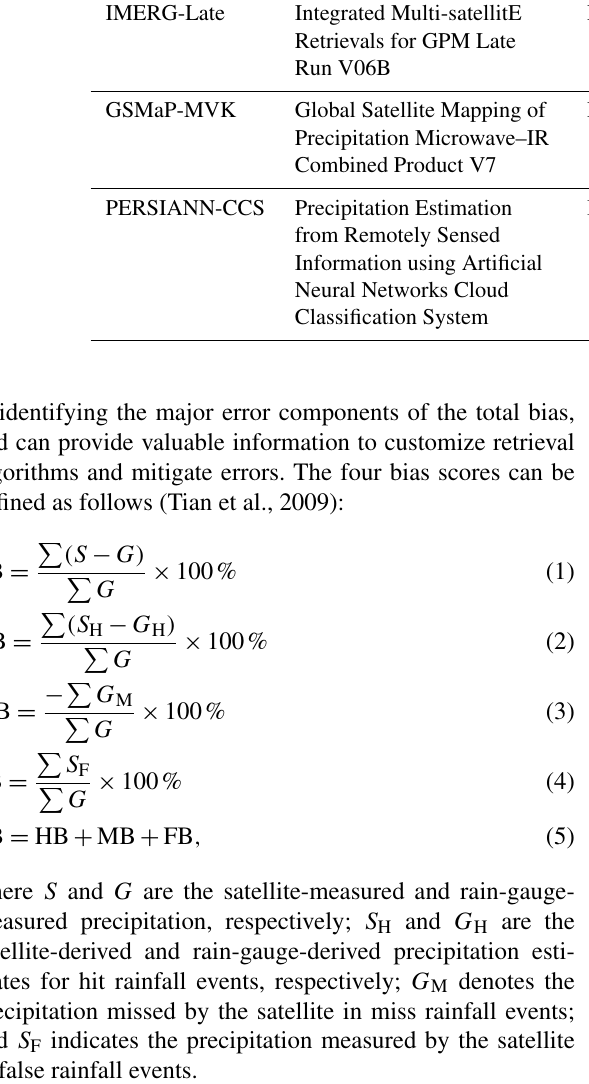
Table 1. Information about the three satellite-only global precipitation estimates used in this study.